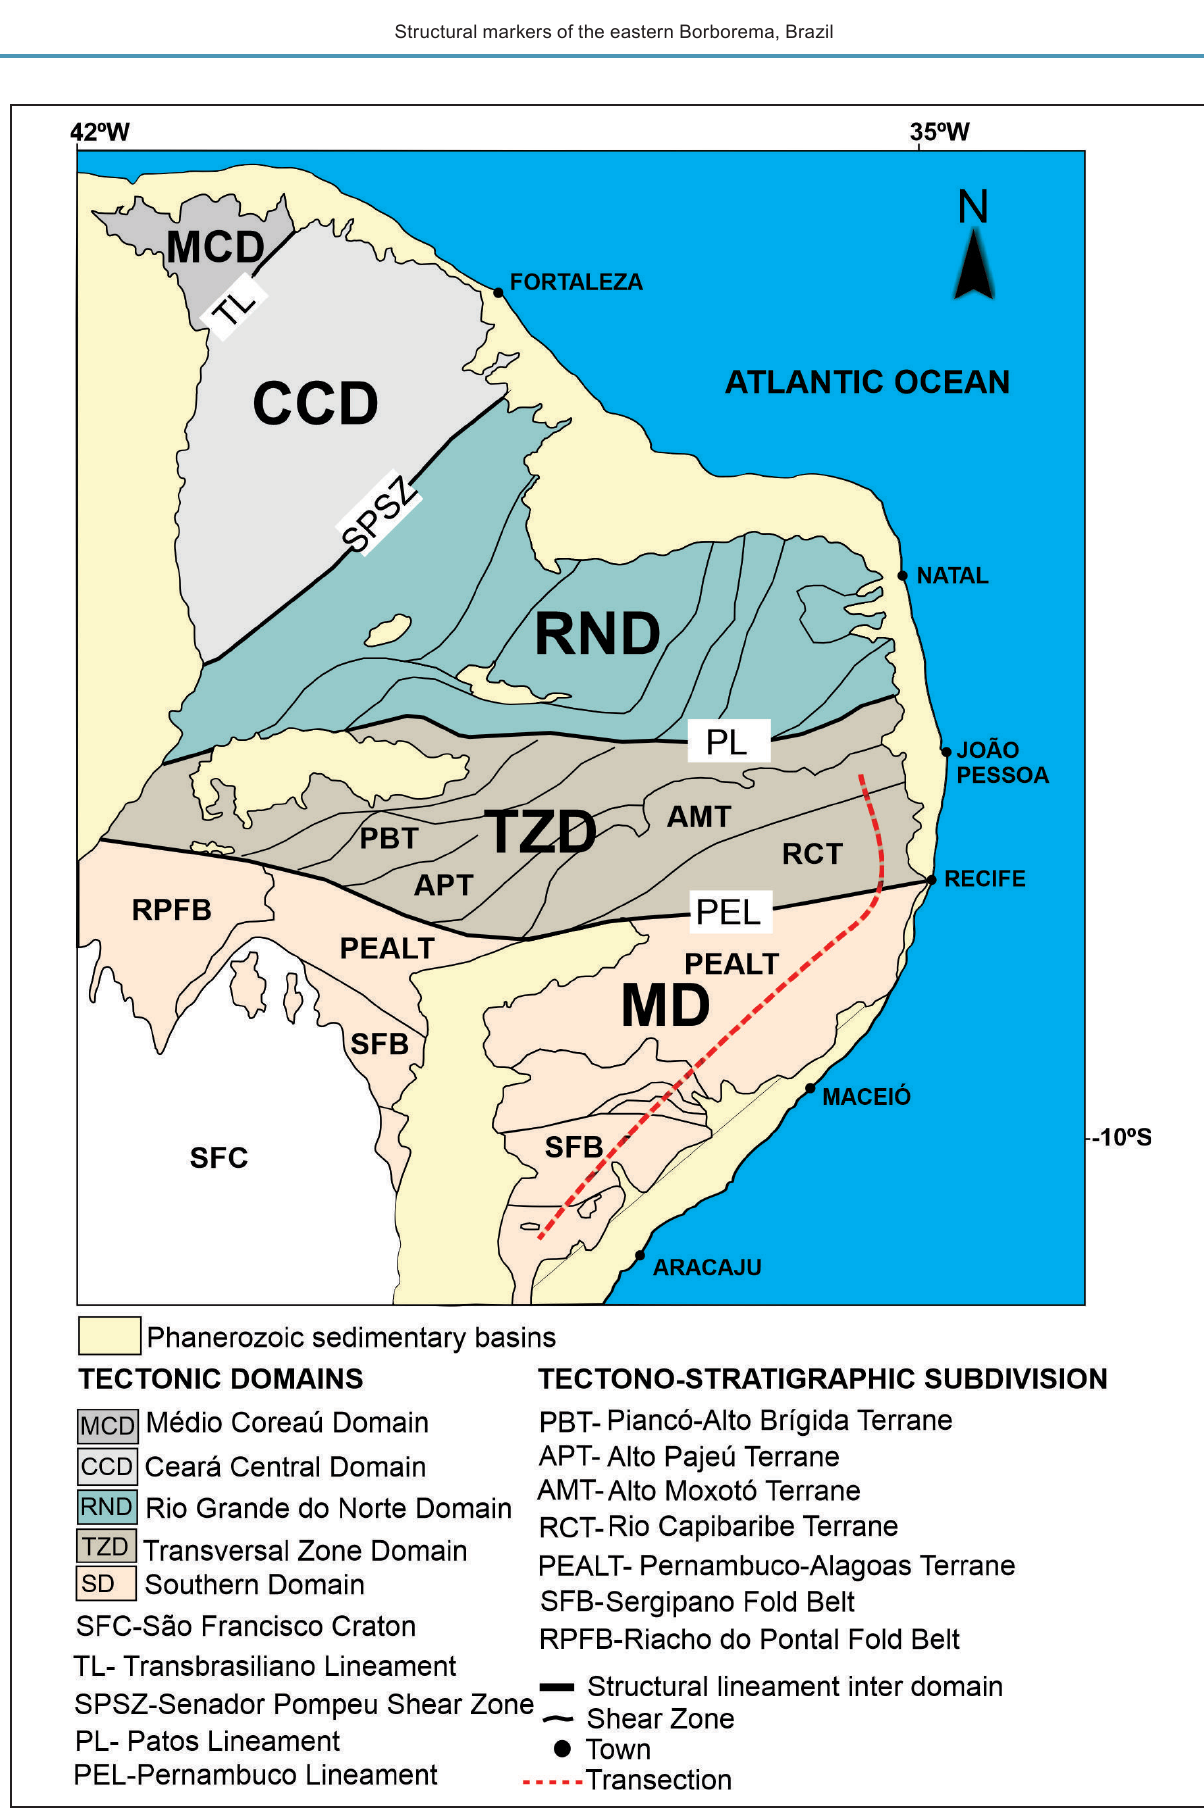
FIGURE 1 . Tectonic framework of the Borborema Province showing its major internal domains as well as the geological transect described in this paper. The figure model is according to from Brito Neves et al.